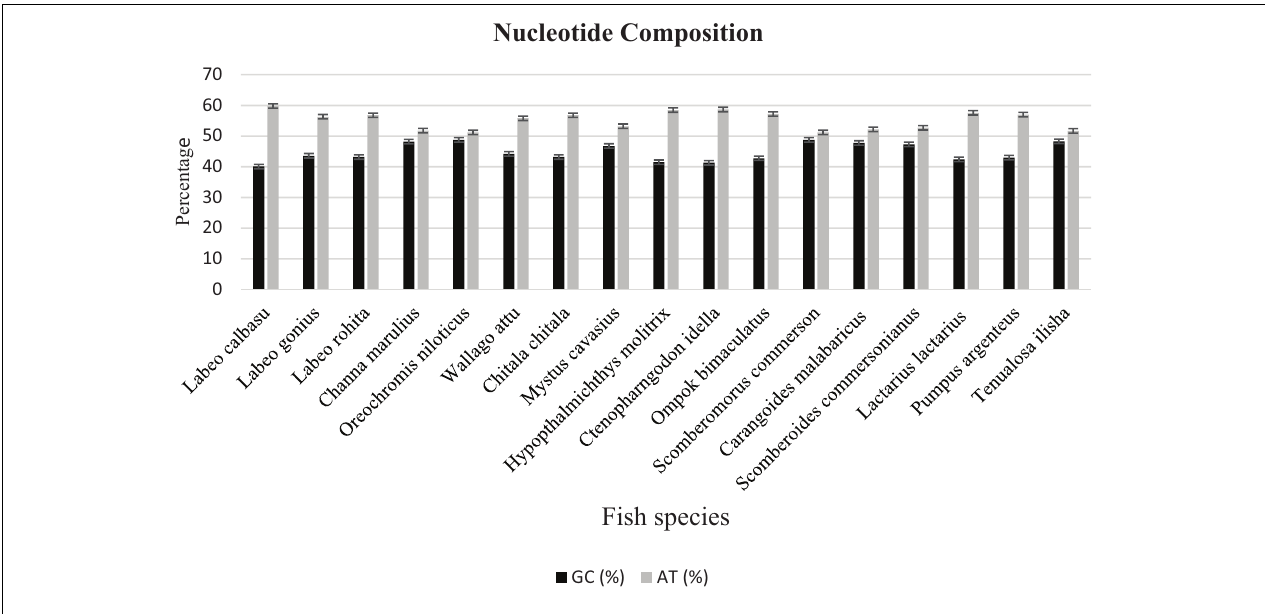
FIGURE 3 | Comparison of the nucleotide compositions between freshwater and marine fish species.